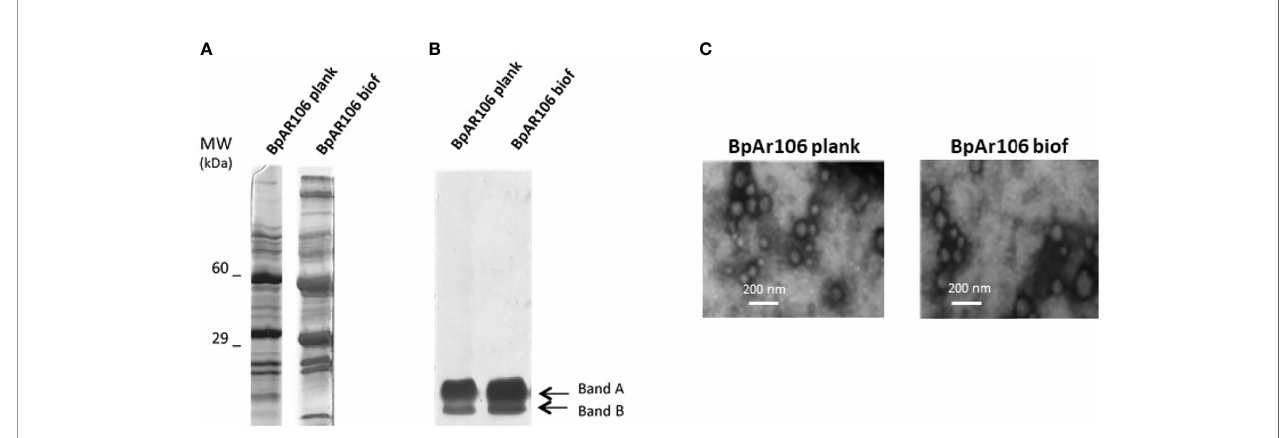
FIGURE 4 | (A) SDS-PAGE (12.5%) of OMV derived from B . pertussis BpAR106 grown under planktonic or bio fi lm culture conditions. Molecular weights are indicated at the left. (B) Lipo-oligosaccharides content in OMVplank and OMVbiof suspensions normalized by total protein content. (C) Scanning electron micrographs of negative stained OMV obtained from B . pertussis BpAR106 grown under planktonic or bio fi lm culture conditions (scale bar: 200 nm).